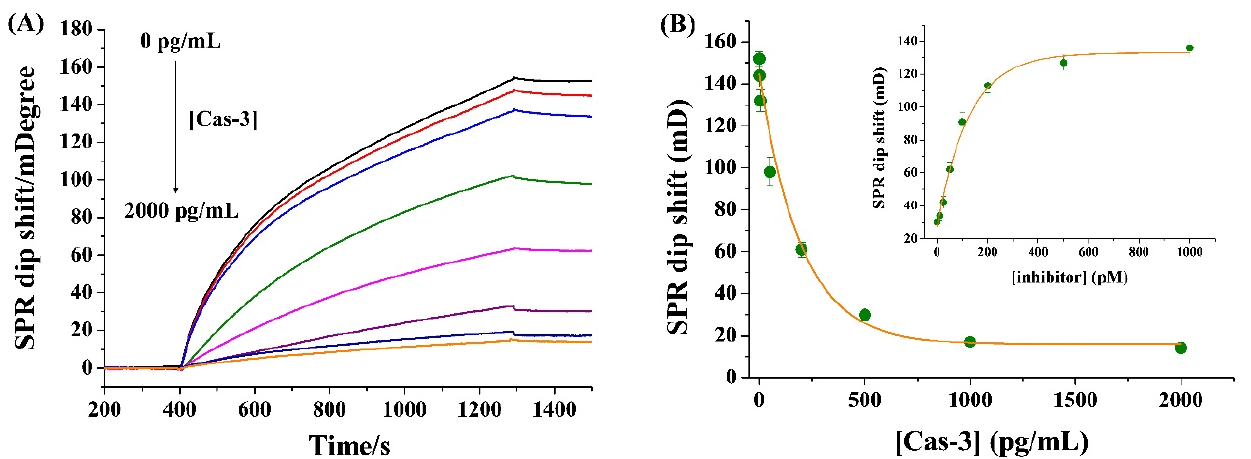
Figure 2. ( A ) SPR sensorgrams when injecting 0.02 mg/mL SA-IgG onto the NA-covered chips treated by the mixture of 5 nM bio-GDEVDGK-bio and a given concentration of Cas-3 (from top to bottom: 0, 0.5, 5, 50, 200, 500, 1000, and 2000 pg/mL). ( B ) Dependence of SPR signal on the concentration of Cas-3. The inset shows the effect of inhibitor concentration on the SPR signal wherein the concentration of Cas-3 was 500 pg/mL. Table 1. An overview of heterogeneous methods for Cas-3 detection based on the signal amplification of enzymes and